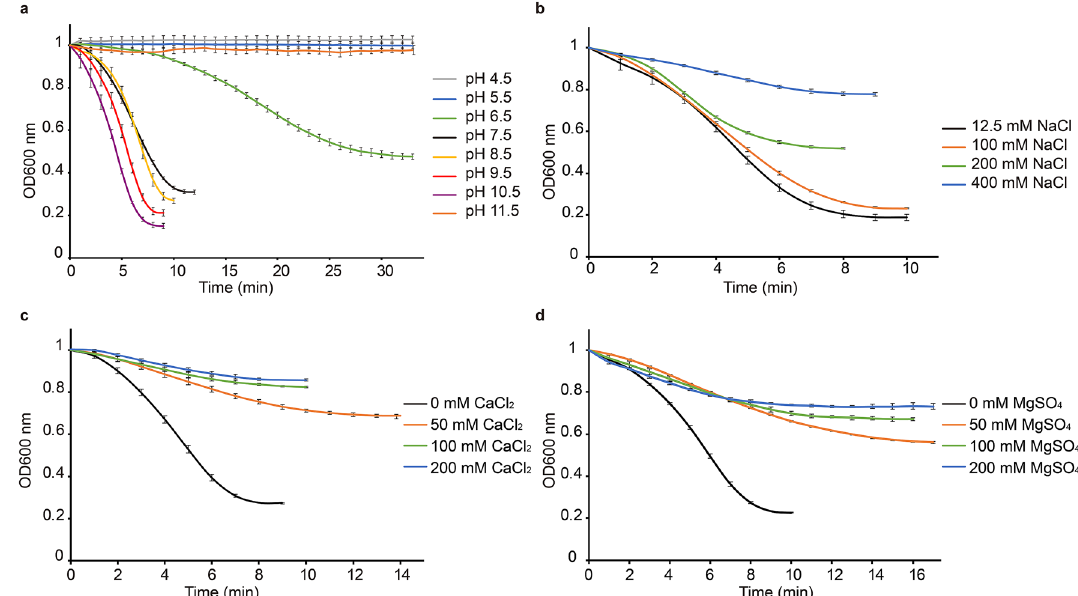
Figure 3. Effects of pH, NaCl, CaCl 2 and MgSO 4 on the lytic activity of CBO1751. Lytic activity analysis by measuring OD 600 of Clostridium botulinum ATCC3502 frozen cells after addition of DB or 5 µM CBO1751 at pH from 4.5 to 11.5 ( a ) or in the presence of 12.5–400 mM NaCl ( b ), 0–200 mM CaCl 2 ( c ) or 0–200 mM MgSO 4 ( d ). All OD 600 values were normalized to an initial OD 600 of 1 and adjusted by subtraction of the corresponding DB control values. Results are indicated as means of three replicates ± standard deviations.